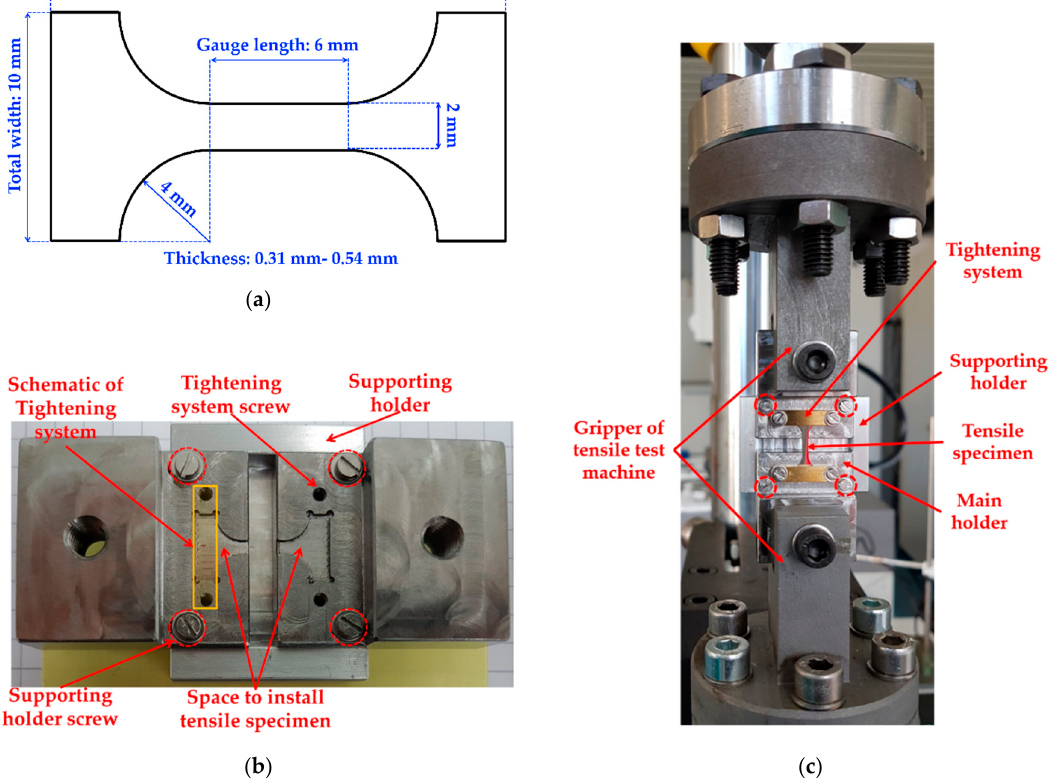
Figure 9. ( a ) Schematic picture of the dog-bone tensile specimen used in this work. The thickness